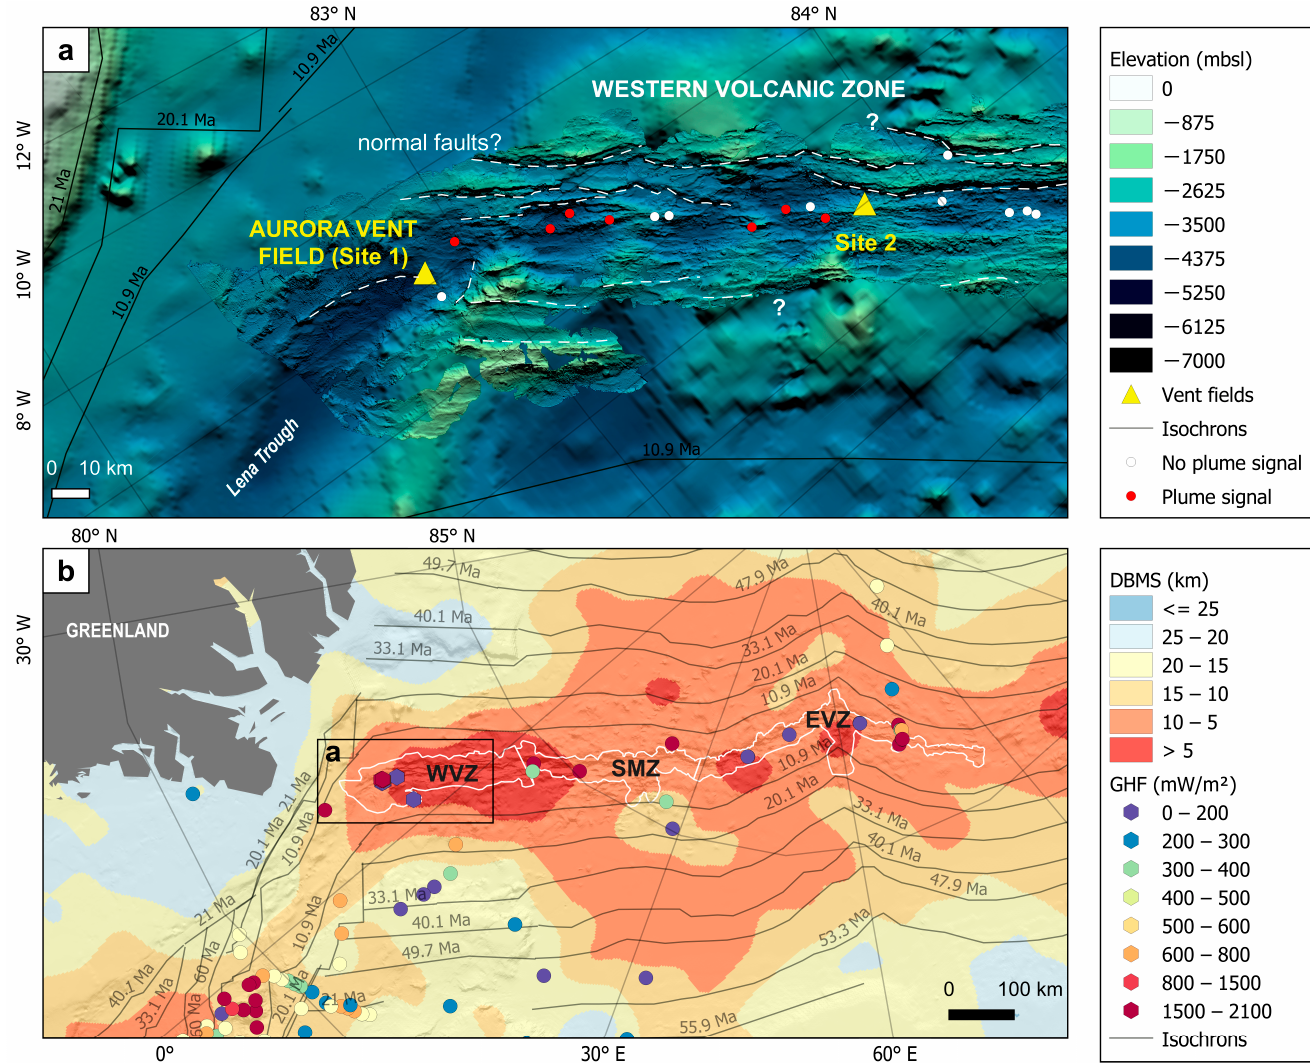
Figure 12. ( a ) Bathymetric map of the Western Volcanic Zone (WVZ) of the Gakkel Ridge. Aurora Volcanic Vent Field [21] located in the ridge center towards Lena Trough. Oceanic crustal ages from [60], water column plume signatures from [21] and vent fields from [61]. Dashed white lines indicate assumed locations of detachment faults. ( b ) Larger overview of the Gakkel Ridge and the Western Volcanic Zone (WVZ), Sparsely Magmatic Zone (SMZ), and Eastern Volcanic Zone (EVZ) after [7]. The depth-to-the-bottom of the magnetic source (DBMS) is based on EMAG2 [35]. Color-coded circles mark geothermal heat flow (GHF) sites from [62] and this study (PS86). Small inlet map shows extents of panel ( a ).